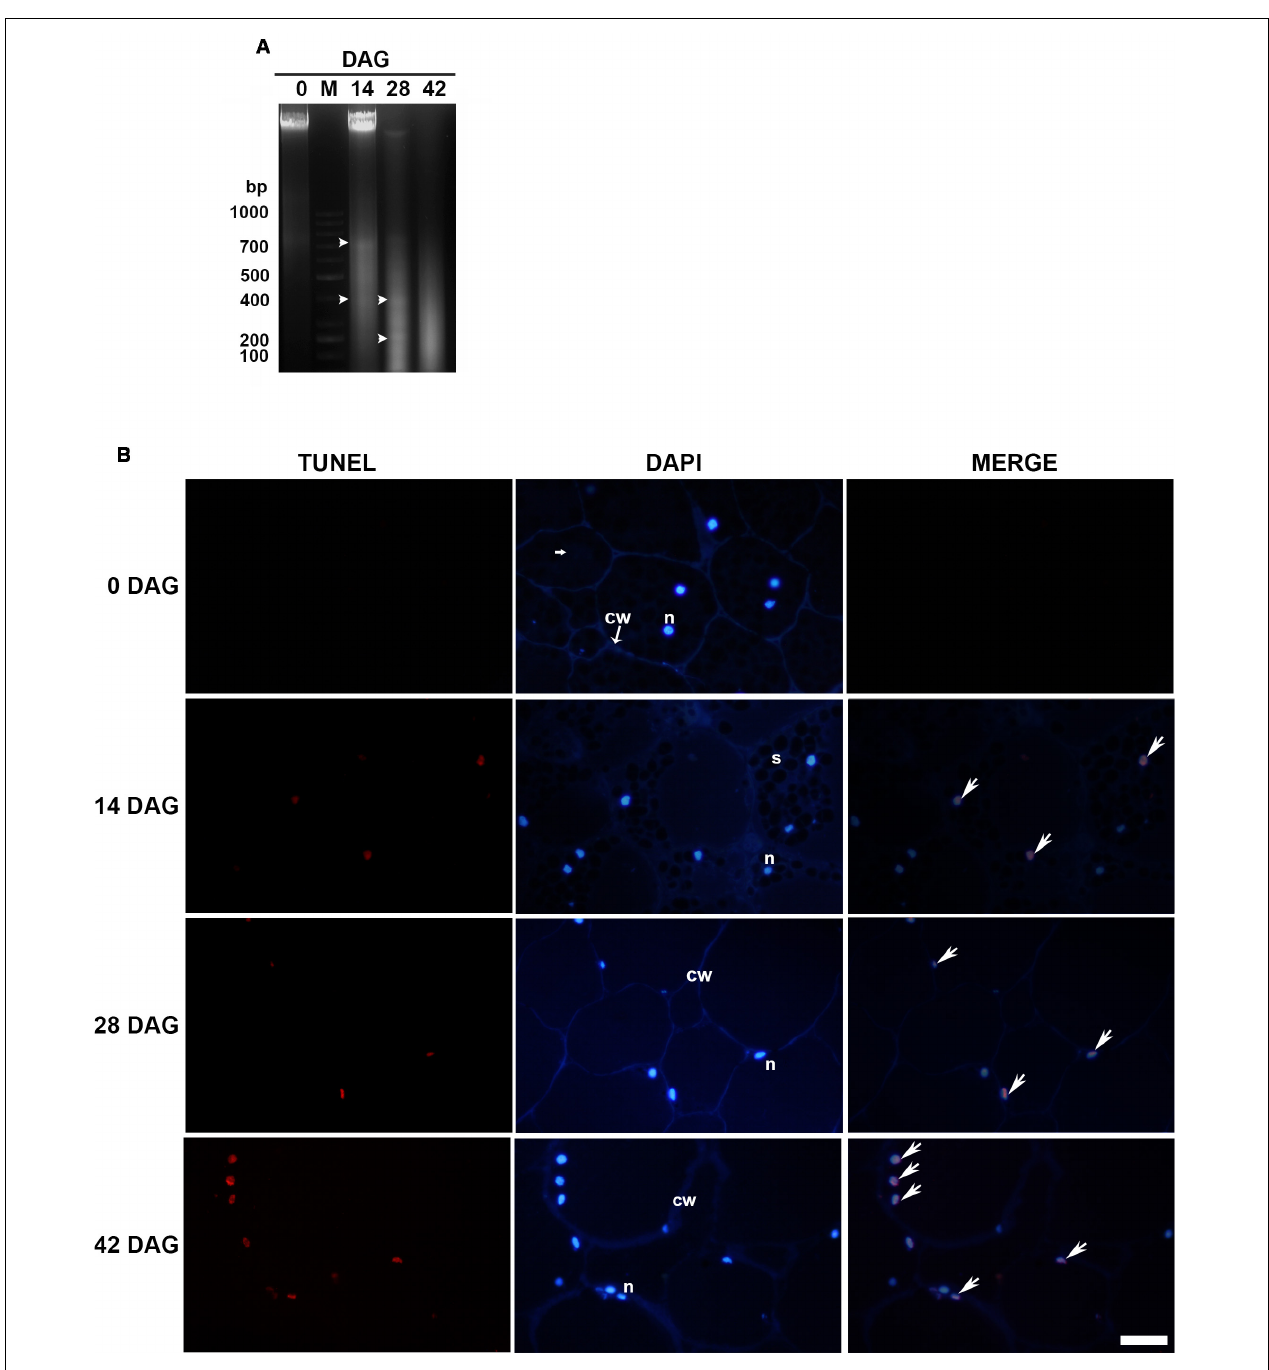
FIGURE 2 | (A) Genomic DNA fragmentation assay. Analyses were repeated at least three times on independent biological samples, and representative results are shown. Lane M. 1 kb ladder, Lanes 1, 3, 4, and 5 correspond to 0, 14, 28, and 42 DAG, respectively. Bands are indicated by arrowheads (B) TUNEL assay (left column) and DAPI staining (central column) were performed on LRW tissue sections at 0, 14, 28, and 42 DAG. Merged images (right column) confirmed that DAPI co-labeled TUNEL-positive nuclei. Scale bar = 50 µ m. Each image is a representative result of observation of at least 5 semi-thin sections of megagametophyte tissue at different